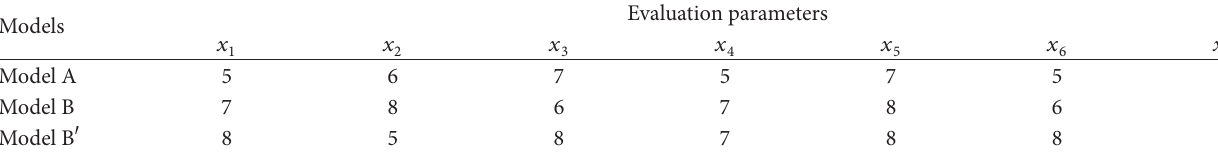
Table 5: Models’ scores of every evaluation